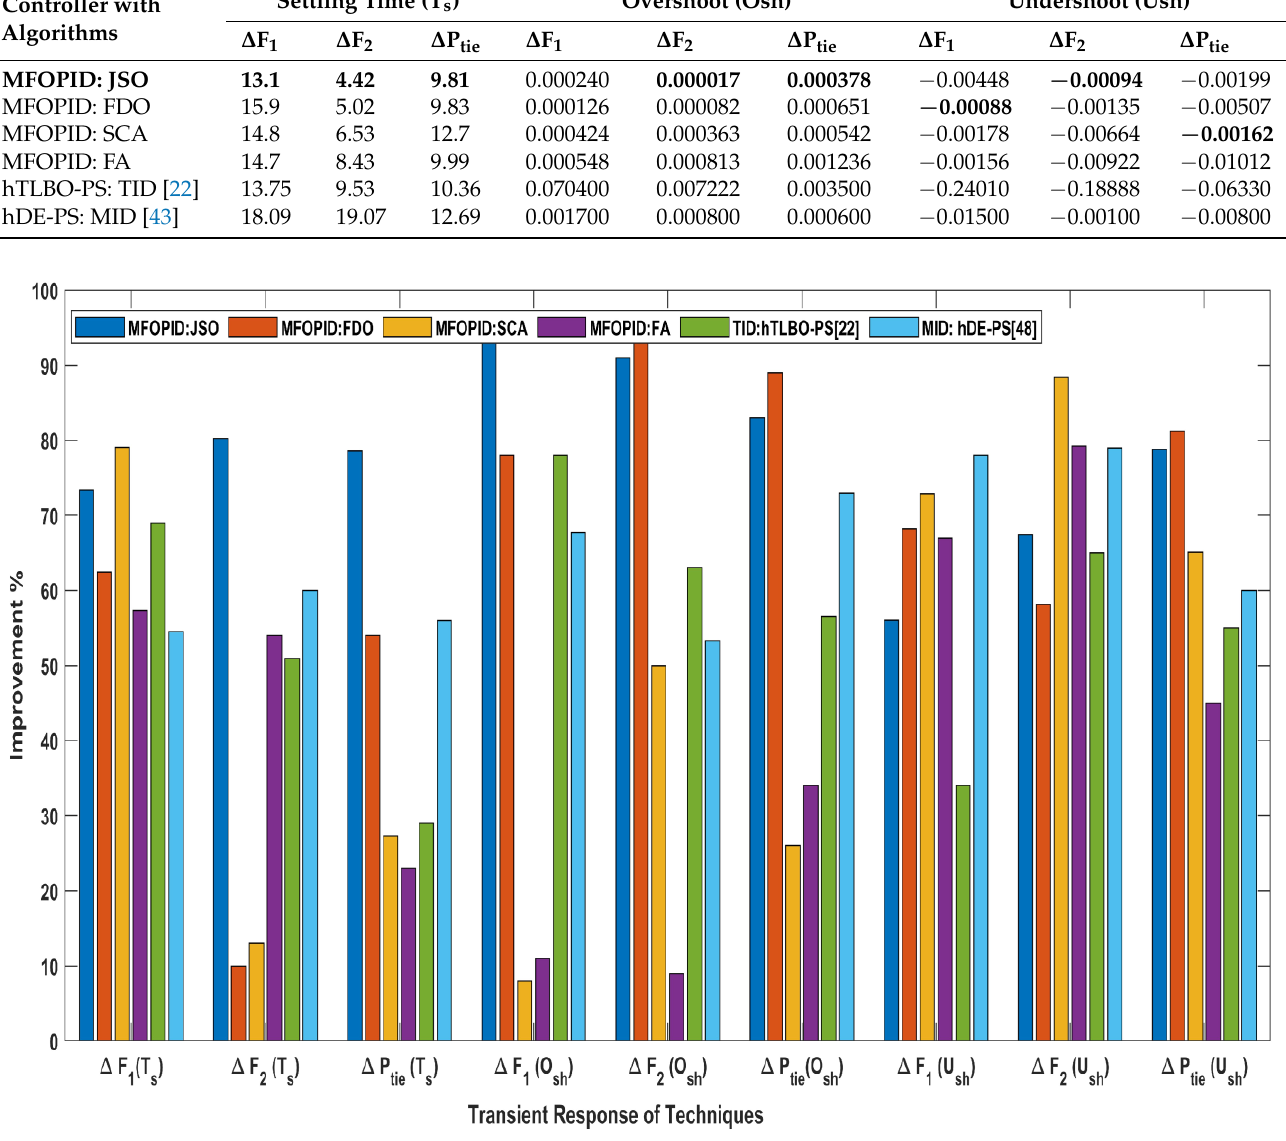
Figure 9. Bar graph of percentage improvement considering case